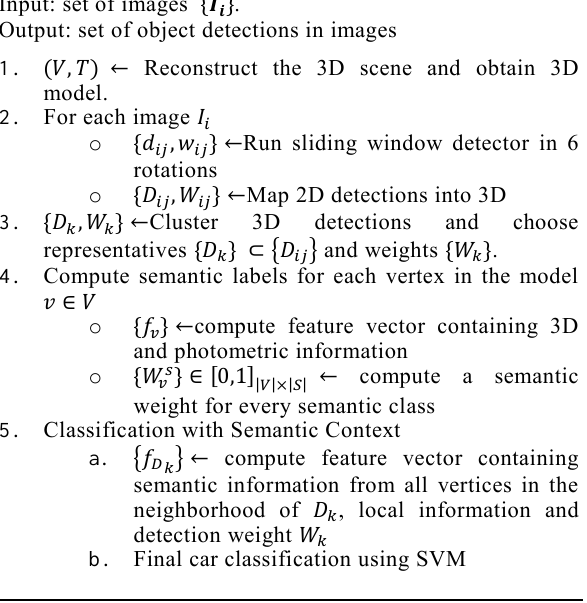
Algorithm 1: object detection in multiple overlapping views